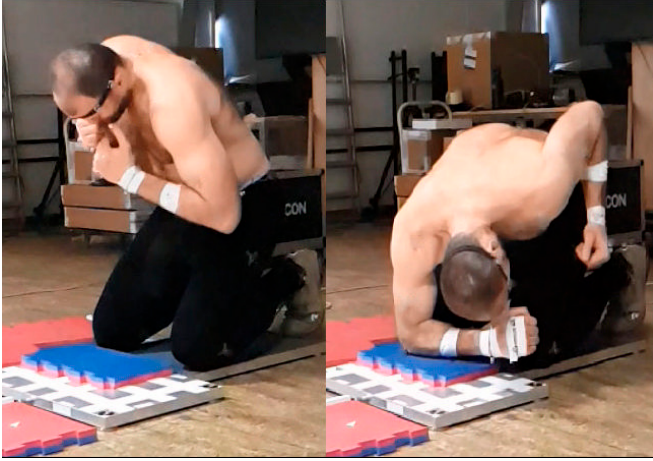
Figure 1. Start (left part) and finish (right part) positions for the elbow “ground” strike.